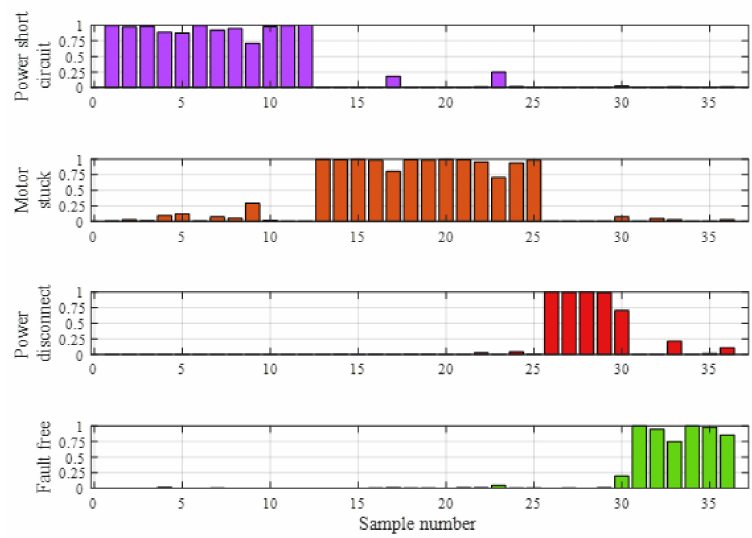
Figure 11. Belief distribution of diagnostic results of each